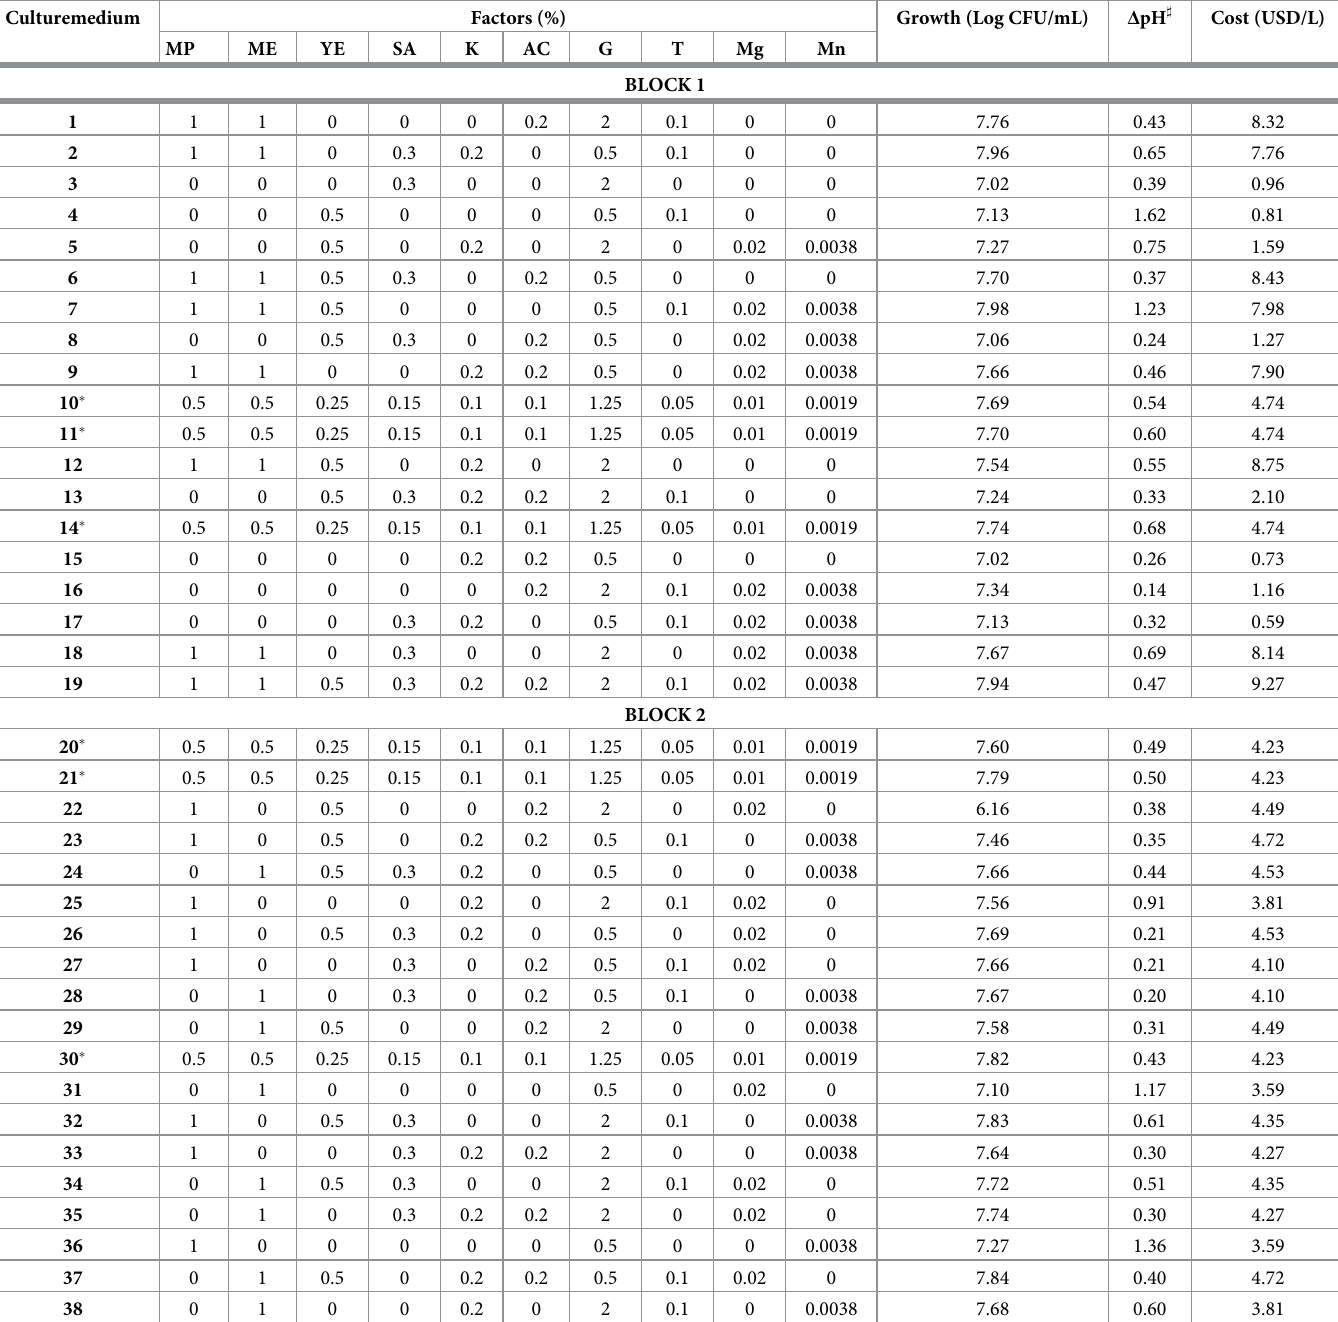
Table 1. Fractional factorial design and results of L . reuteri CRL1098 biomass production, Δ pH and cost of different growth medium.